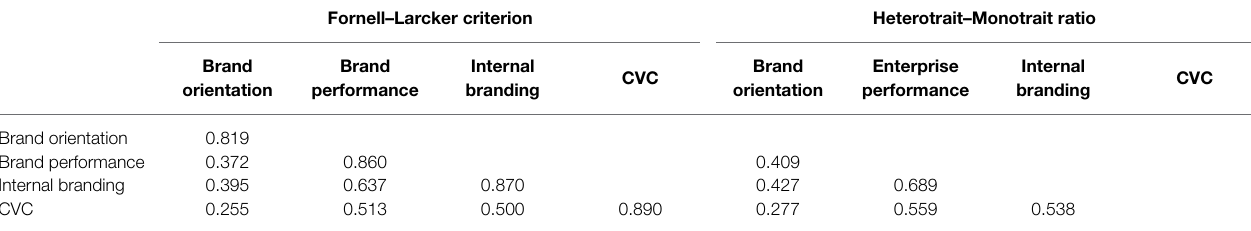
TABLE 3 | Discriminant